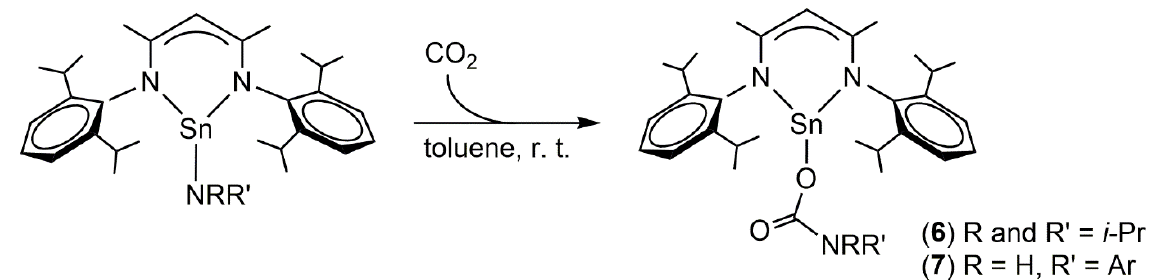
Figure 4. Molecular structure of 5 , adapted from [52] (MERCURY view). Hydrogen atoms are omitted for clarity (Sn light blue, O red, N dark blue, C grey). Intermolecular hydrogen bonds are shown by cyan dash lines.